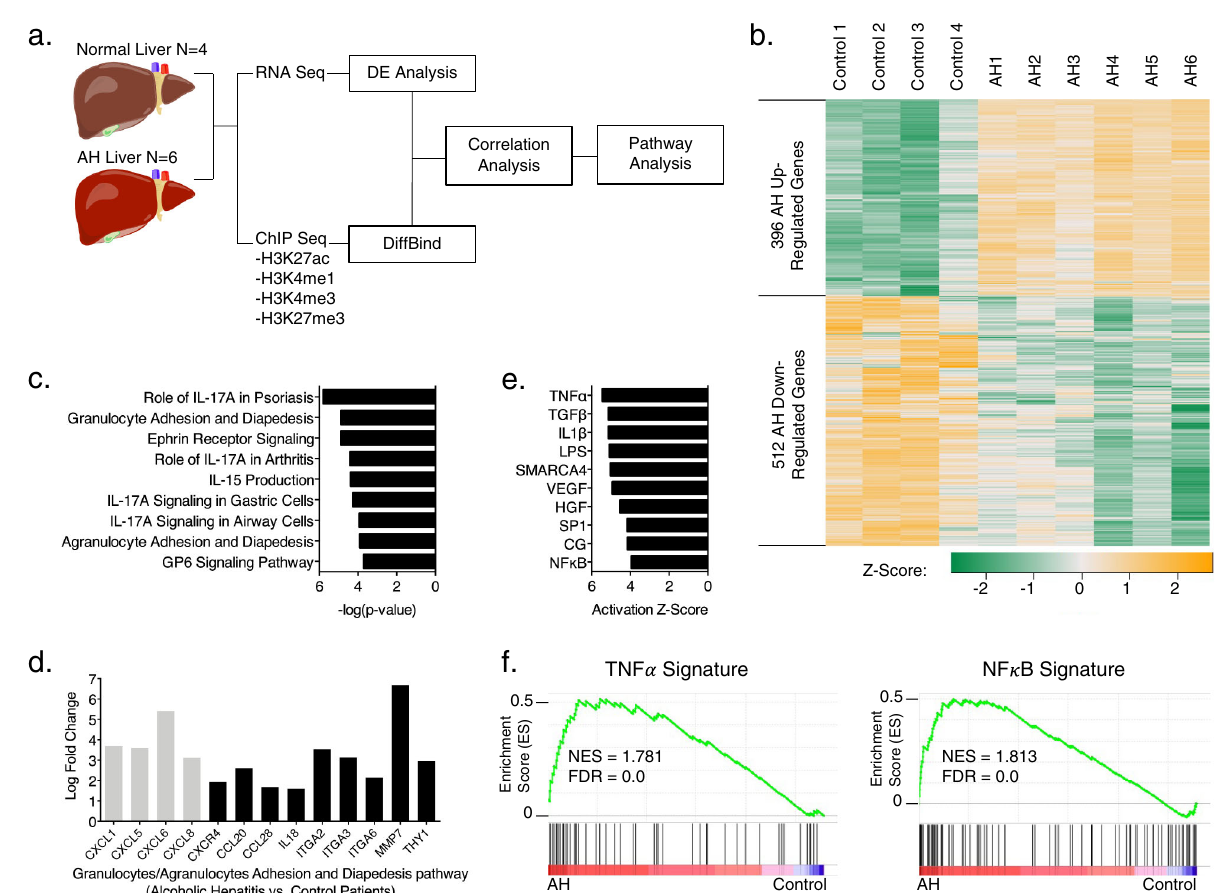
Fig. 1 RNA-seq and histone mark ChIP-seq of AH and normal livers show signi fi cant differences. a Schematic of RNA-seq and ChIP-seq analyses pipeline. b Heatmap of differentially expressed genes from the integrated analysis of RNA-seq and ChIP-seq (gold: upregulated genes; green: downregulated genes). c IPA of upregulated genes from the integrated analysis. Top ten affected canonical pathways are listed along with their respective inverse log of p values. Right-tailed Fisher ’ s Exact Test was used for the calculation of p values. d Differentially expressed genes from the granulocytes/ agranulocytes adhesion and diapedesis pathways are listed. Four CXCL chemokines 1, 5, 6, and 8 are located at the same locus and are colored light gray. e Upstream regulator analysis from IPA. Top ten activated upstream regulators are listed along with their respective normalized z -scores. f GSEA of TNF α and NF- κ B pathway target genes. AH enriched genes are plotted to the left and control enriched genes are plotted to the right. Normalized enrichment score (NES) and false discovery rate (FDR) are listed for the modi fi ers, including SMARCA4 and SP1, that are activated in AH (Fig. 1e). SMARCA4 regulates accessibility to the chromatin 19 , and SP1 interacts with histone-modifying enzymes to affect gene expression 20 . The upregulation of epigenetic modi fi er pathways supports a role for epigenetic regulation in AH.